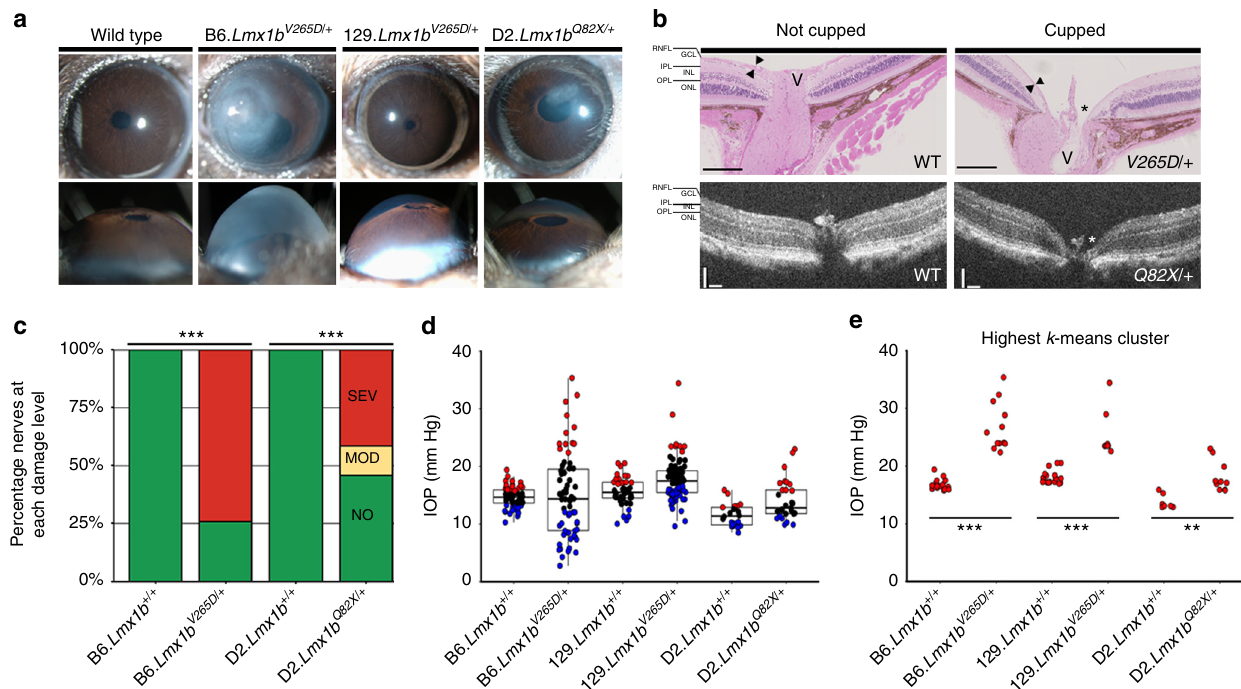
Fig. 4 Lmx1b can induce high IOP and glaucoma in developmentally normal eyes. a Slit lamp examination of control B6. Lmx1b + / + , B6. Lmx1b V265D/ + , 129. Lmx1b V265D/ + , and D2. Lmx1b Q82X/ + at 9 months of age. All D2 mice were wild-type (WT) for Gpnmb. Lmx1b WT eyes on all backgrounds were developmentally normal and so only the B6 controls are shown. B6 mutant mice have a severe developmental phenotype, involving severely malformed eccentric pupils, irido-corneal strands, corneal haze, and corneal scleralization (upper panels). These developmental phenotypes are much milder or absent in mutants on the other backgrounds, with about 50% of mutants on the 129 background having very mild pupillary abnormalities. No mutants on the D2 background had developmental abnormalities. In WT eyes, we can distinguish a very shallow anterior chamber, and, as a result of IOP elevation, the chamber depth increases to different degrees in mutants on each genetic background (lower panels). N ≥ 30 for each group. b Optic nerve cupping (asterisks) and retinal nerve fi ber layer (RNFL) thinning (arrowheads), two hallmarks of glaucoma, was present in mutant eyes with severely affected optic nerves but not in WT eyes (10 months ’ B6 H&E-stained sections, top panels, and 13 months ’ D2 eyes SD-OCT images shown, bottom panels). Scale bar = 200 μ m for H&E-stained images and 100 μ m for SD-OCT images. V optic vessel, GCL ganglion cell layer, IPL inner plexiform layer, INL inner nuclear layer, OPL outer plexiform layer, ONL outer nuclear layer. c Nerve damage plots for 10-month B6 and 14.5-month-old D2 eyes N ≥ 24 for each group, Fisher ’